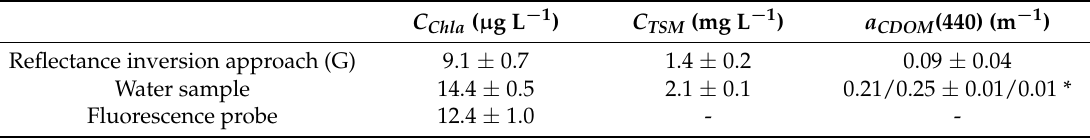
Table 4. Water constituents as retrieved from above-water reflectance under variable cloud cover with correction of cloud reflection and surface reflection originating from Rayleigh scattered light (Errors represent the variability of the fit results)—Results from water sample analysis and in-situ probe